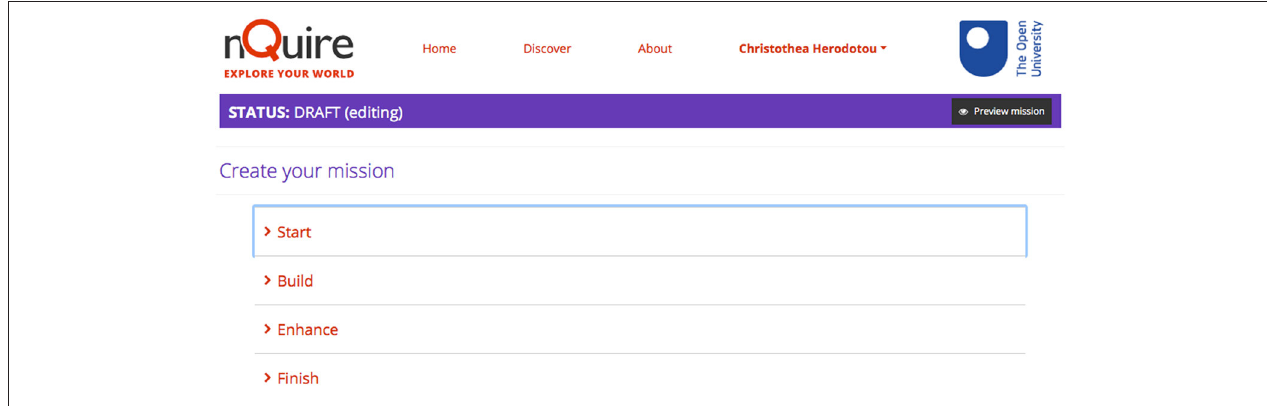
FIGURE 2 | The authoring tool enabling design of high quality CS projects on nQuire.